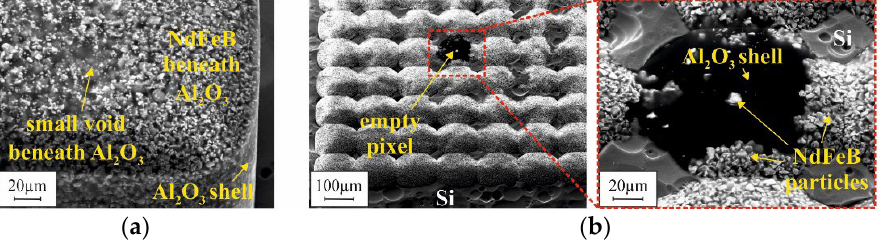
Figure 17. SEM micrographs of the bottom side of micromagnets, obtained by automated mold filling, after removal of the surrounding silicon in XeF 2 gas phase as illustrated in Figure 15. ( a ) Structure of R1000 design showing a small void. ( b ) Structure of G2 design exhibiting a pixel that is empty in the lower part and detailed view of this pixel (area within the red square). All micrographs were made with an acceleration voltage of 20 kV.